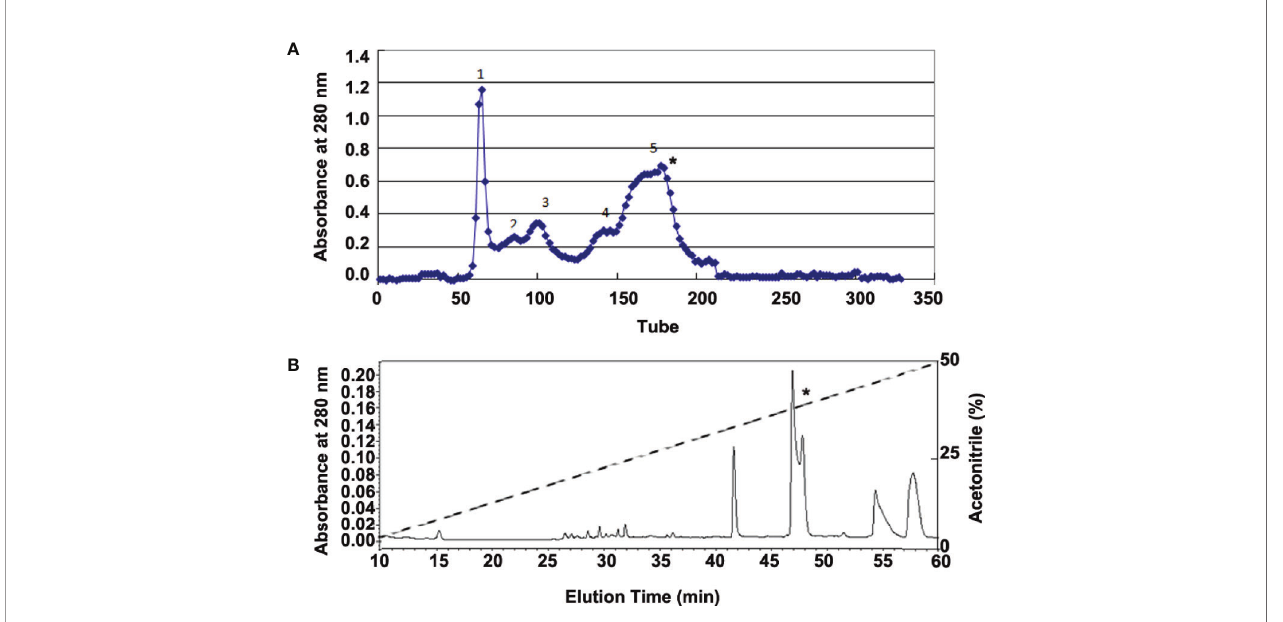
FIGURE 1 | Puri fi cation of bioactive peptides from skin secretions of H. annectans . (A) Lyophilized skin secretion sample of H. annectans. was subjected to Sephadex G-75 gel fi ltration; the elution was performed by 0.1M PBS with a fl ow rate of 0.3 mL/min. (B) Fraction 5 from (A) was further puri fi ed by RP-HPLC (Hypersil BDS C18, 25×0.46 cm) column. The elution was performed at a fl ow rate of 0.7 mL/min with gradients of acetonitrile in 0.1% (v/v) tri fl uoroacetic acid (TFA) in water. The fractions with the interested peptides are marked with